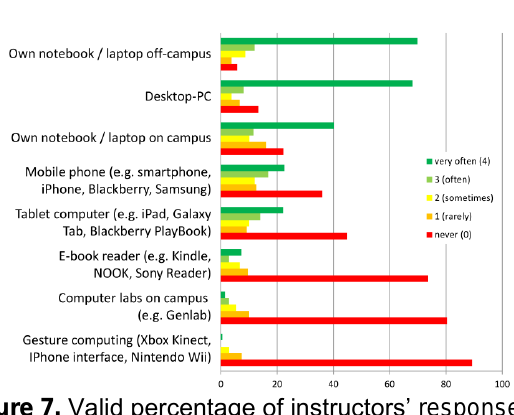
Figure 7. Valid percentage of instructors’ responses